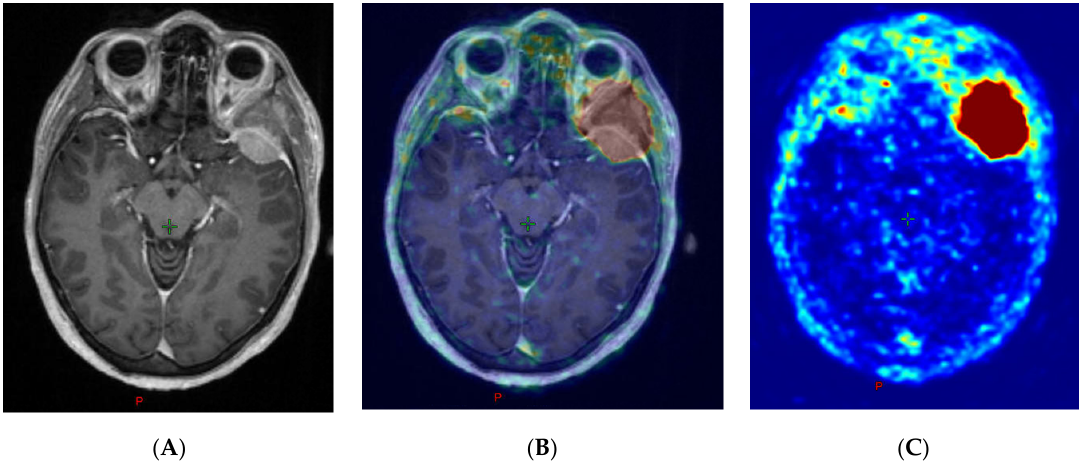
Figure 3. [68Ga]Ga-68-labeled [DOTA0-Phe1-Tyr3] octreotide (Ga-68-DOTATOC)-PET windowing according to MRI. ( A ) MRI, T1-weighted sequences with magnetization-prepared rapid acquisition with gradient echo; ( B ) PET windowing orientating on areas with sharp tumor demarcation in MRI using coregistered PET/MRI; ( C ) attenuation-corrected PET data.